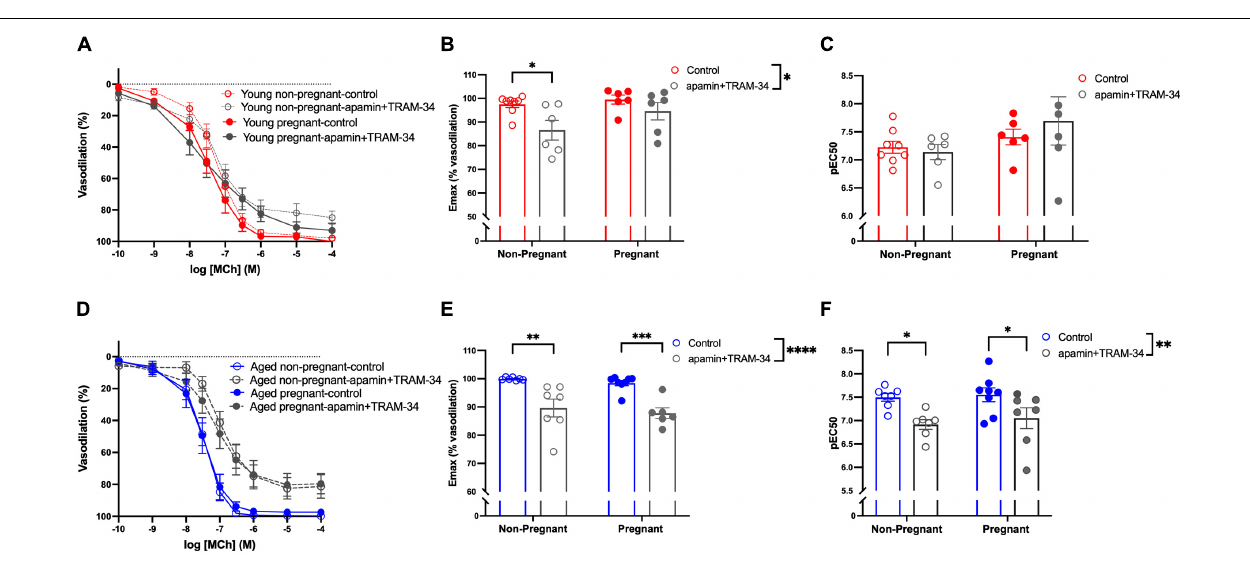
Frontiers in Physiology |